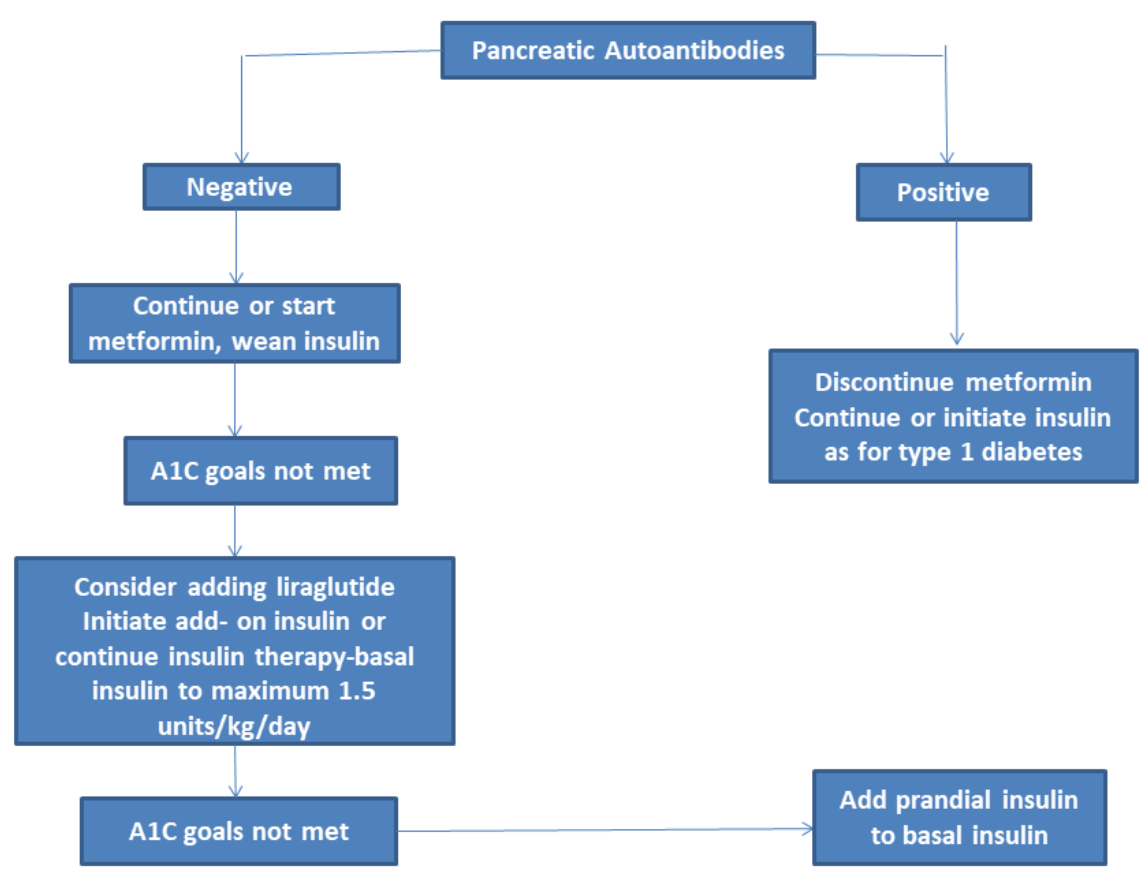
Figure 2. Goal-directed management of type 2 diabetes mellitus (T2DM) in youth. Adapted from American Diabetes, A., 13. Children and Adolescents: Standards of Medical Care in Diabetes-2020. Diabetes Care 2020 , 43 (Suppl. 1),